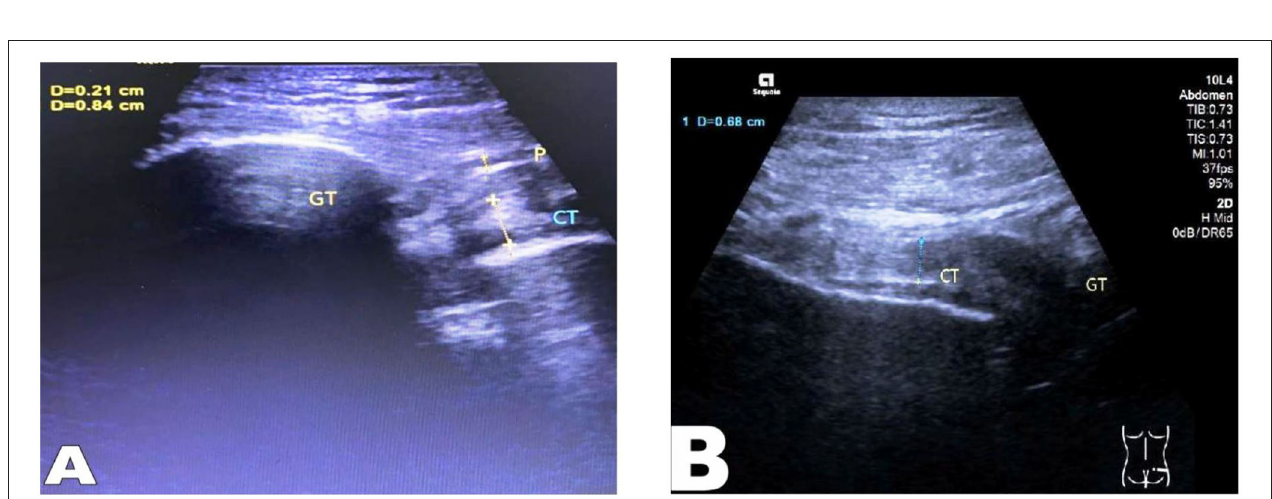
FIGURE 3 | Musculoskeletal ultrasound examination, (A) “CT” indicates the preoperative conjoint tendon morphology; “GT” indicates the greater trochanter of femur; (B) “CT” indicates the conjoint tendon morphology after repaired, with good tendon tension.